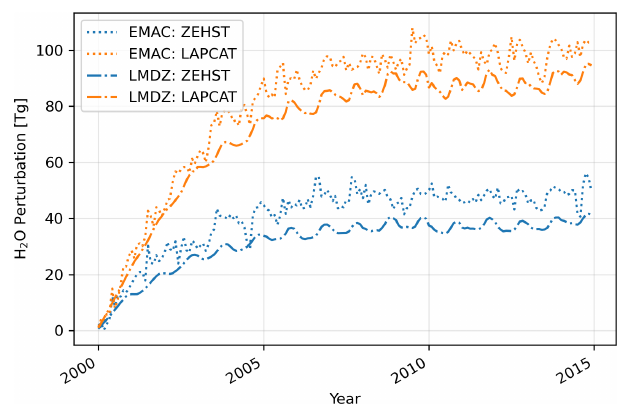
Figure 3. Temporal evolution of mass perturbation of H 2 O in Tg above the tropopause. Blue and orange lines represent the ZEHST and LAPCAT scenarios, respectively. The annual amount of emitted trace gases is listed in Table